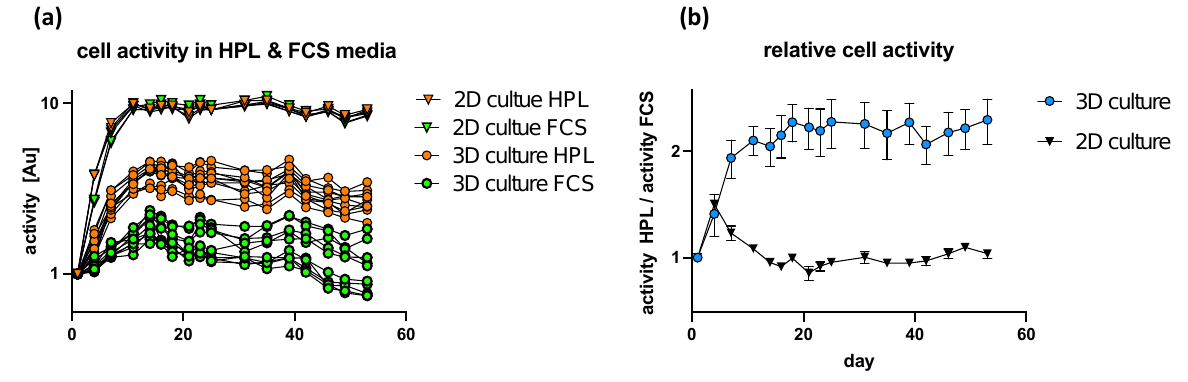
Figure 6. Decellularized nerve as 3D-scaffold for hASC culture. ( a ) 250k hASC were injected per 3D acellular graft (dots), 10k hASC seeded in 2D-culture well as a control (triangles). Cellular activity was analyzed using resazurin every 3–5 days in media supplemented by 10% FCS (green) or 5% HPL and 2 U/mL heparin (orange). Cell activity normalized to cell activity at day 1 post-transplantation. Triangles represent cell activity in 2D-culture plates and dots represent cell activity in 3D-culture. ( b ) cell activity regarding FCS- and HPL-supplemented media. Relative cellular activity of hASC cultured in HPL-supplemented media normalized to relative cellular activity of hASC cultured in FCS-supplemented media. Black triangles represent normalized cell activity in 2D culture and blue dots represent normalized cell activity in 3D.